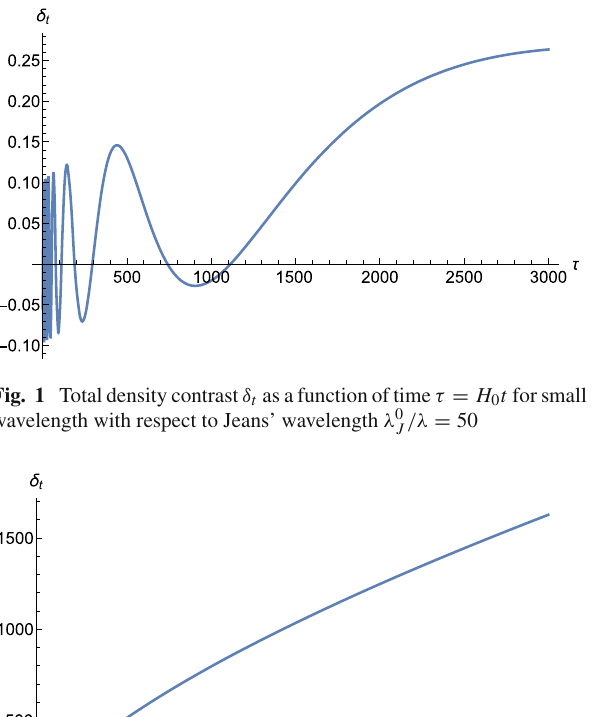
Fig. 4 Density contrasts of baryons δ b and dark matter δ d as functions of time τ = H 0 t for large wavelength with respect to Jeans’ wavelength λ 0 /λ = 0 . J /λ = 0 . 5 J